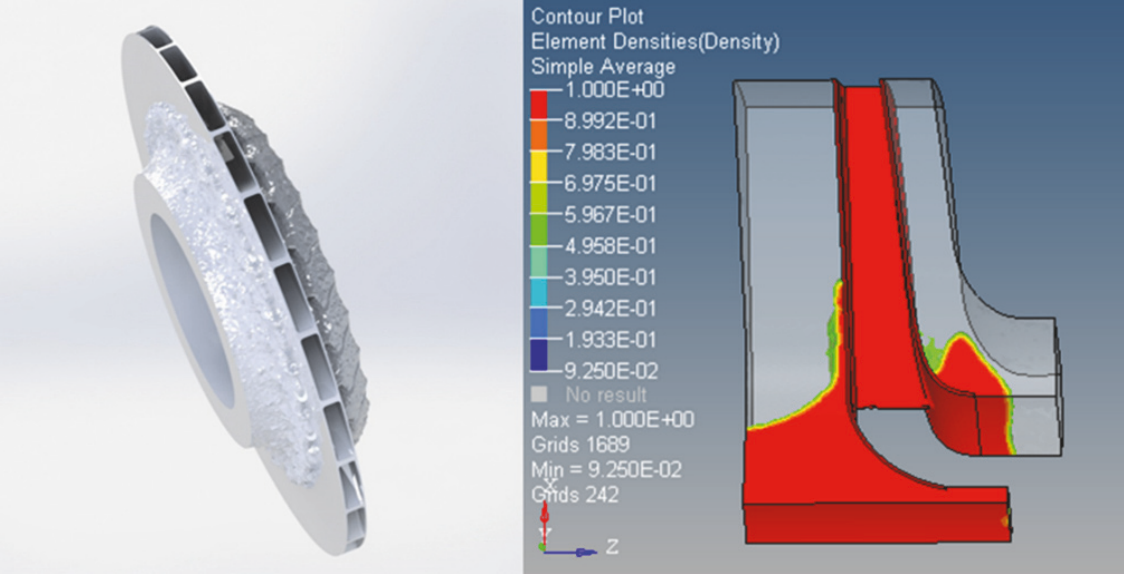
Figure 7: Optimization result for the 2D impeller.